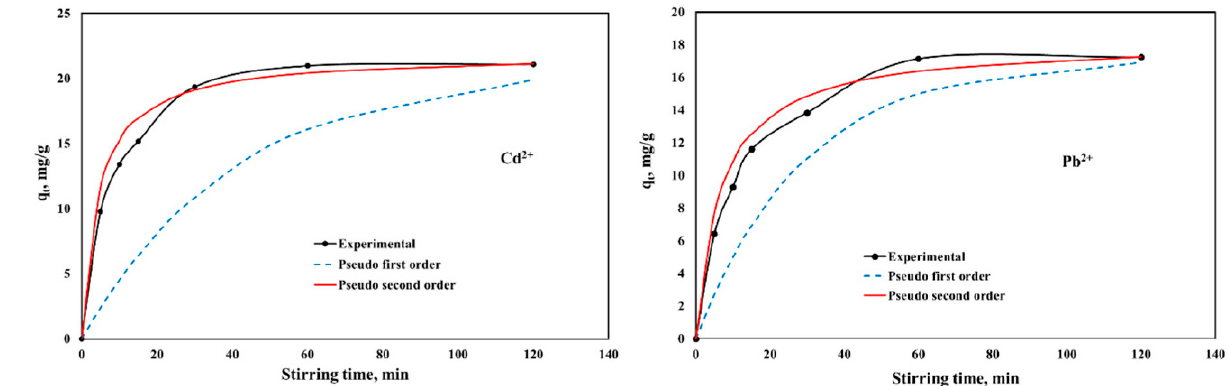
Figure 6. Kinetics of Cd 2+ and Pb 2+ adsorption onto CoCEPPA.